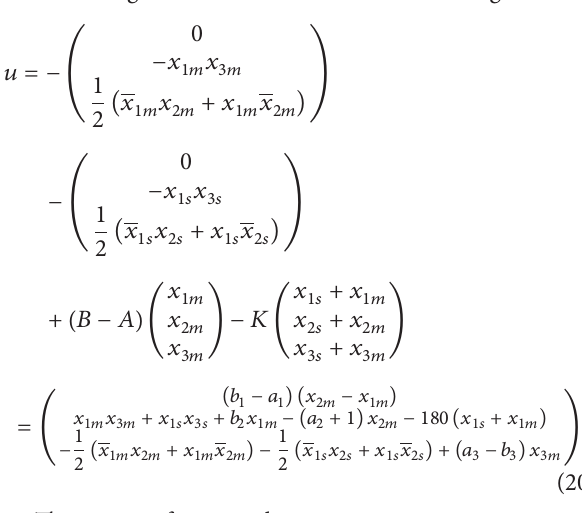
Figure 11: The time evolution of the synchronization errors between systems (15) and (17)